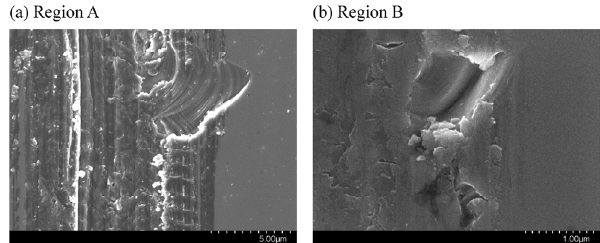
Fig. 11 Wear morphology of the silicon surface after friction with PS and PP